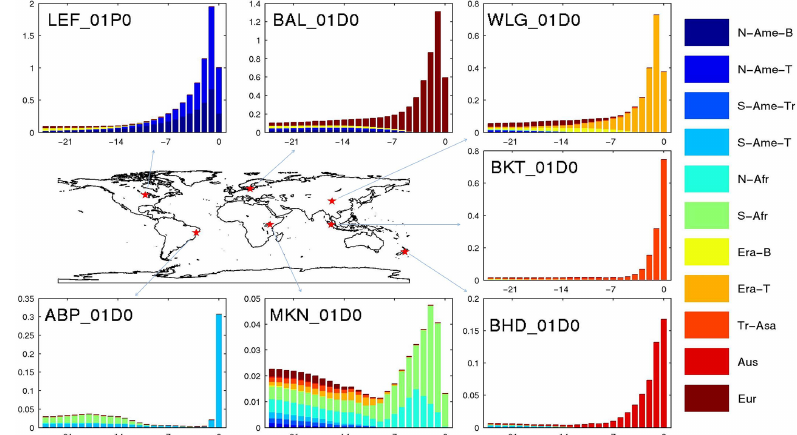
Figure 5. Mean components of CO 2 concentration at observation sites (Site IDs: LEF_01P0, BAL_01D0, WLG_01D0, BKT_01D0, BHD_01D0, MKN_01D0 and ABP_01D0) from 11 Transcom regions in each of the 25 days before the observation time; x axis refers to days before the observation time; y axis refers to the amount of CO 2 concentration in ppm. Different colors within a bar refer to CO 2 concentration from 11 different Transcom regions; 11 regions refer to North American boreal (N-Ame-B), North American temperate (N- Ame-T), South American tropical (S-Ame-Tr), South American temperate (S-Ame-T), northern Africa (N-Afr), southern Africa (S-Afr), Eurasia boreal (Era-B), Eurasia temperate (Era-T), tropical Asia (Tr-Asa), Australia (Aus) and Europe (Eur),